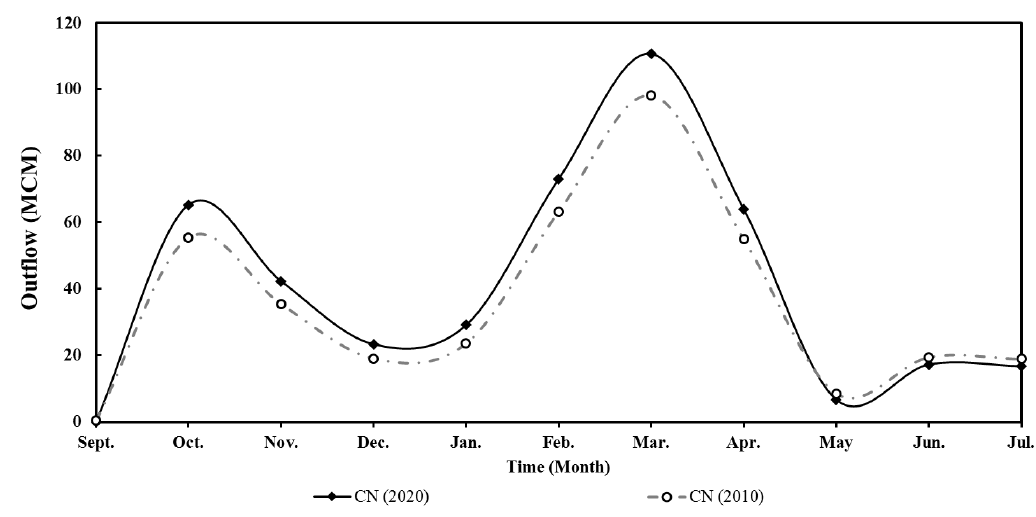
Figure 8. Outflow of the watershed under both status quo and the development